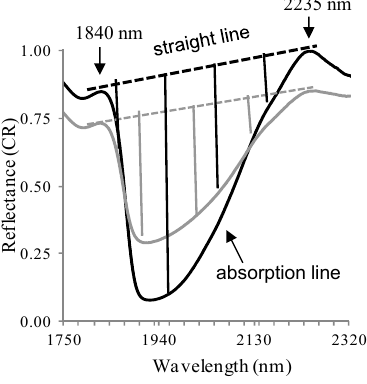
Figure 2. Demonstration of total absorption area of two vegetation samples. The larger area (black) is of sample with low Cl and Na contents, whereas the smaller area (gray) is of sample with high Na and Cl contents.